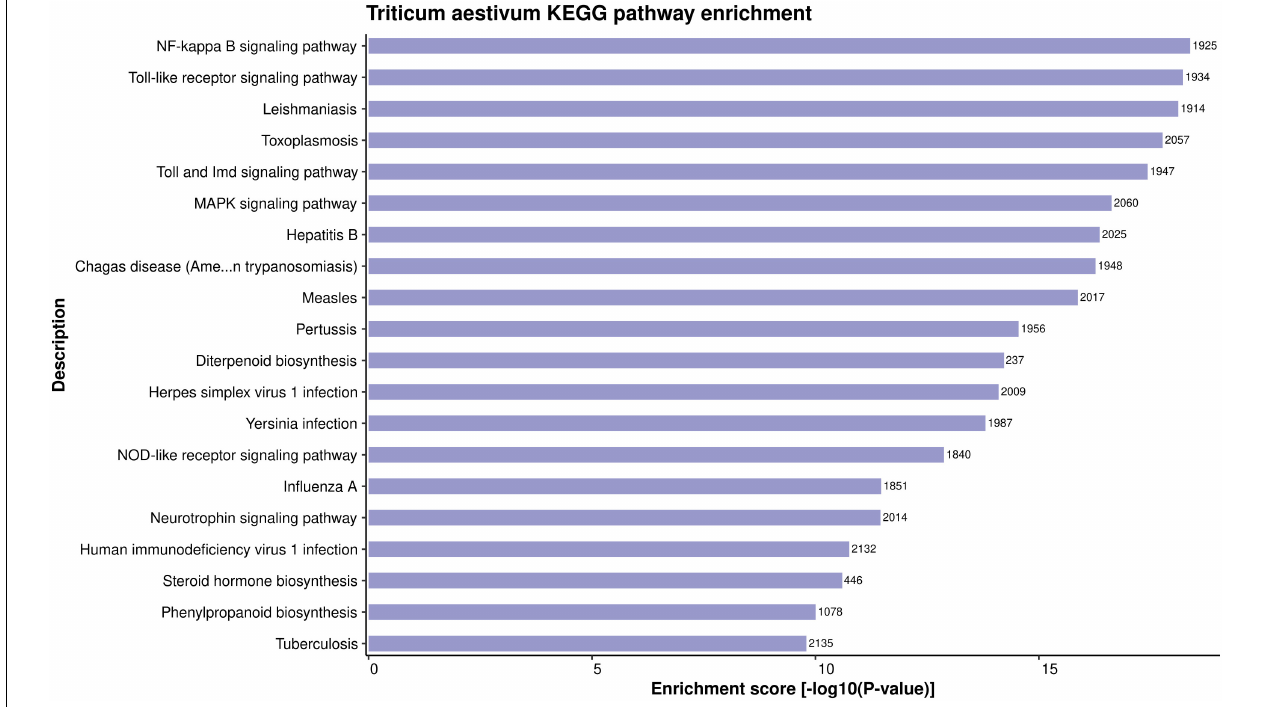
FIGURE 4 | Representation of top 20 enriched KEGG pathways for the host proteins involved in HPIs, based on enrichment